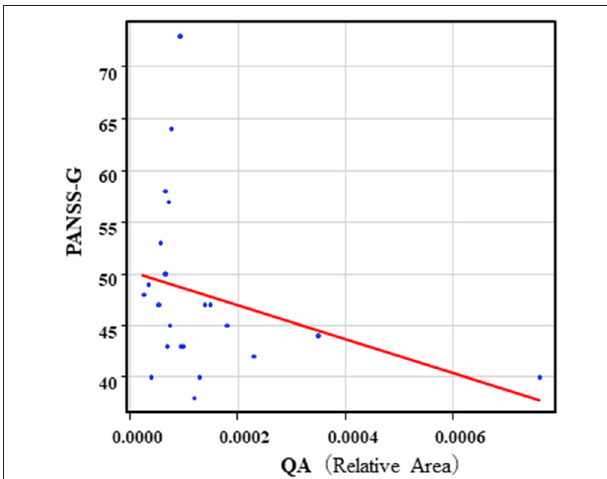
FIGURE 8 | Association between the PANSS-G scores and serum QA levels in the schizophrenia group. A negative correlation was found between the PANSS-G score and serum QA levels ( r = − 0.44, p = 0.043) in the schizophrenia group. Relative Area: The peak areas of the metabolites were normalized against those of the internal standards, and the resultant relative areas were further normalized by the sample amount explained in the Measurement of metabolites of the Kyn pathway. Thus, serum QA levels demonstrated as the ratio comparing with internal standard.